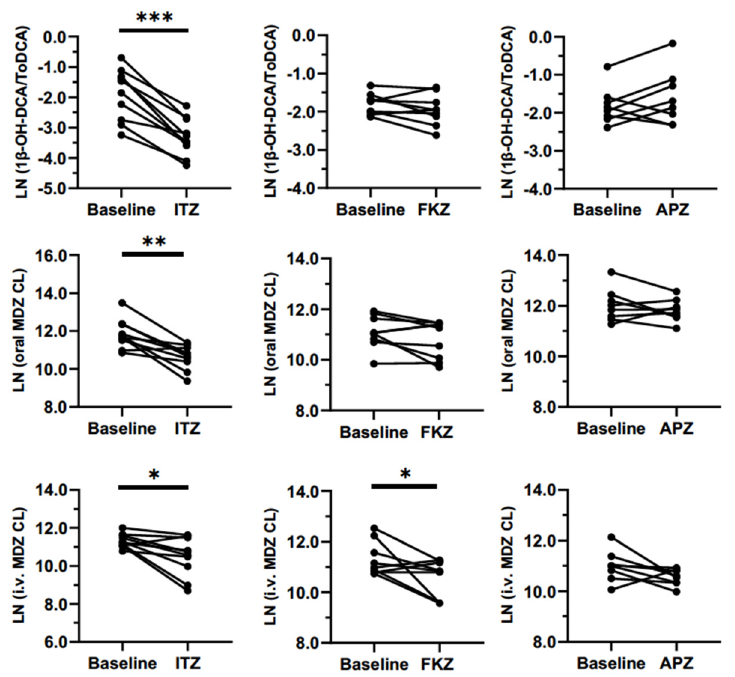
Figure 5. Individual urinary 1 β -OH-DCA/ToDCA UMR (upper panel), oral (middle panel), and i.v. (bottom panel) MDZ clearance (L/h) at baseline and after the repeated administration of ITZ (100 mg od for 6 days), FKZ (50 mg od for 14 days), and APZ (1 mg od for 9 days). * p < 0.05; ** p < 0.01; *** p < 0.001.